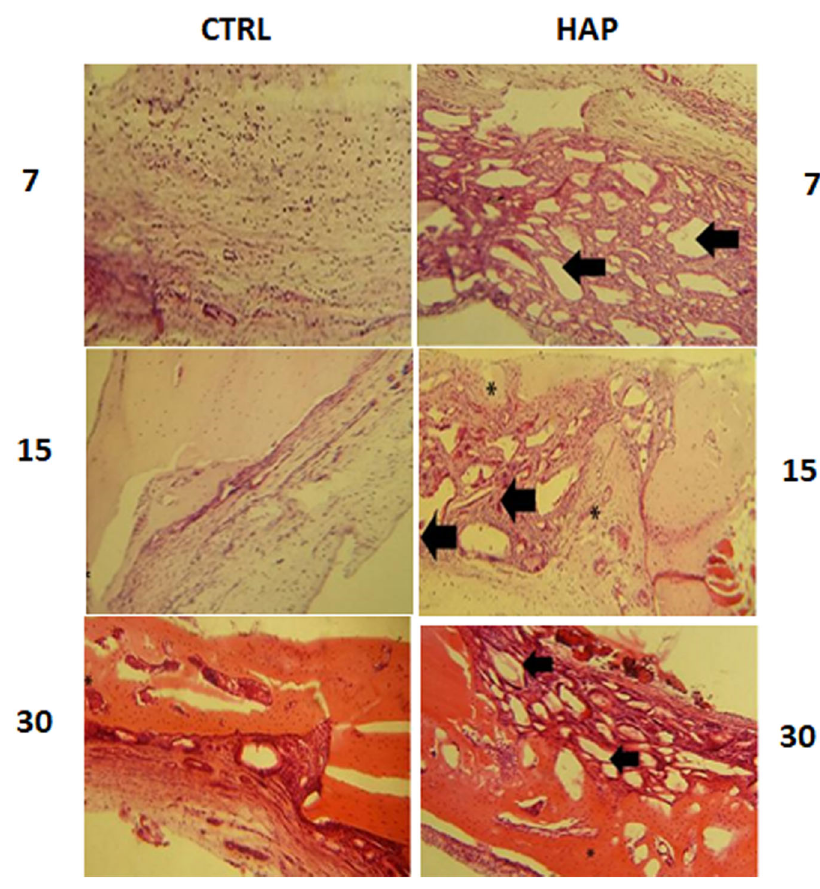
Fig. 4 Photomicrographs of rat calvaria following HAP implantation after 7, 15 and 30 days post-implantation: CTRL control group, HAP hydroxyapatite group. Arrow: HAP; asterisk: bone formation H.,E. stain. ×40 magni fi